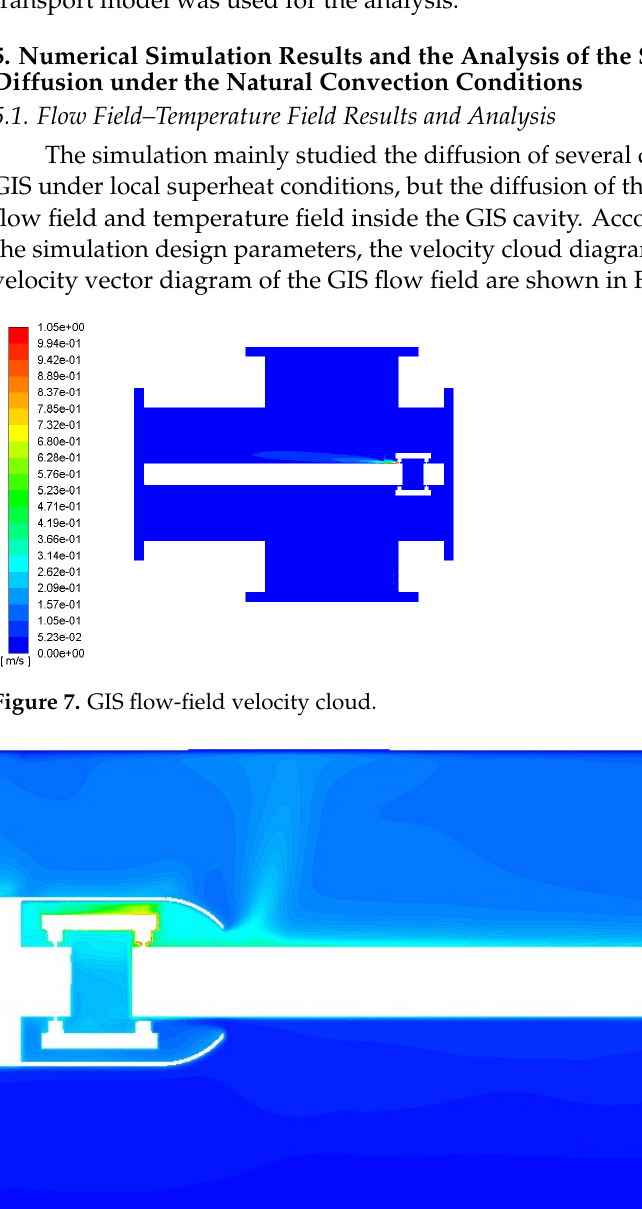
Figure 8. GIS model simulation temperature